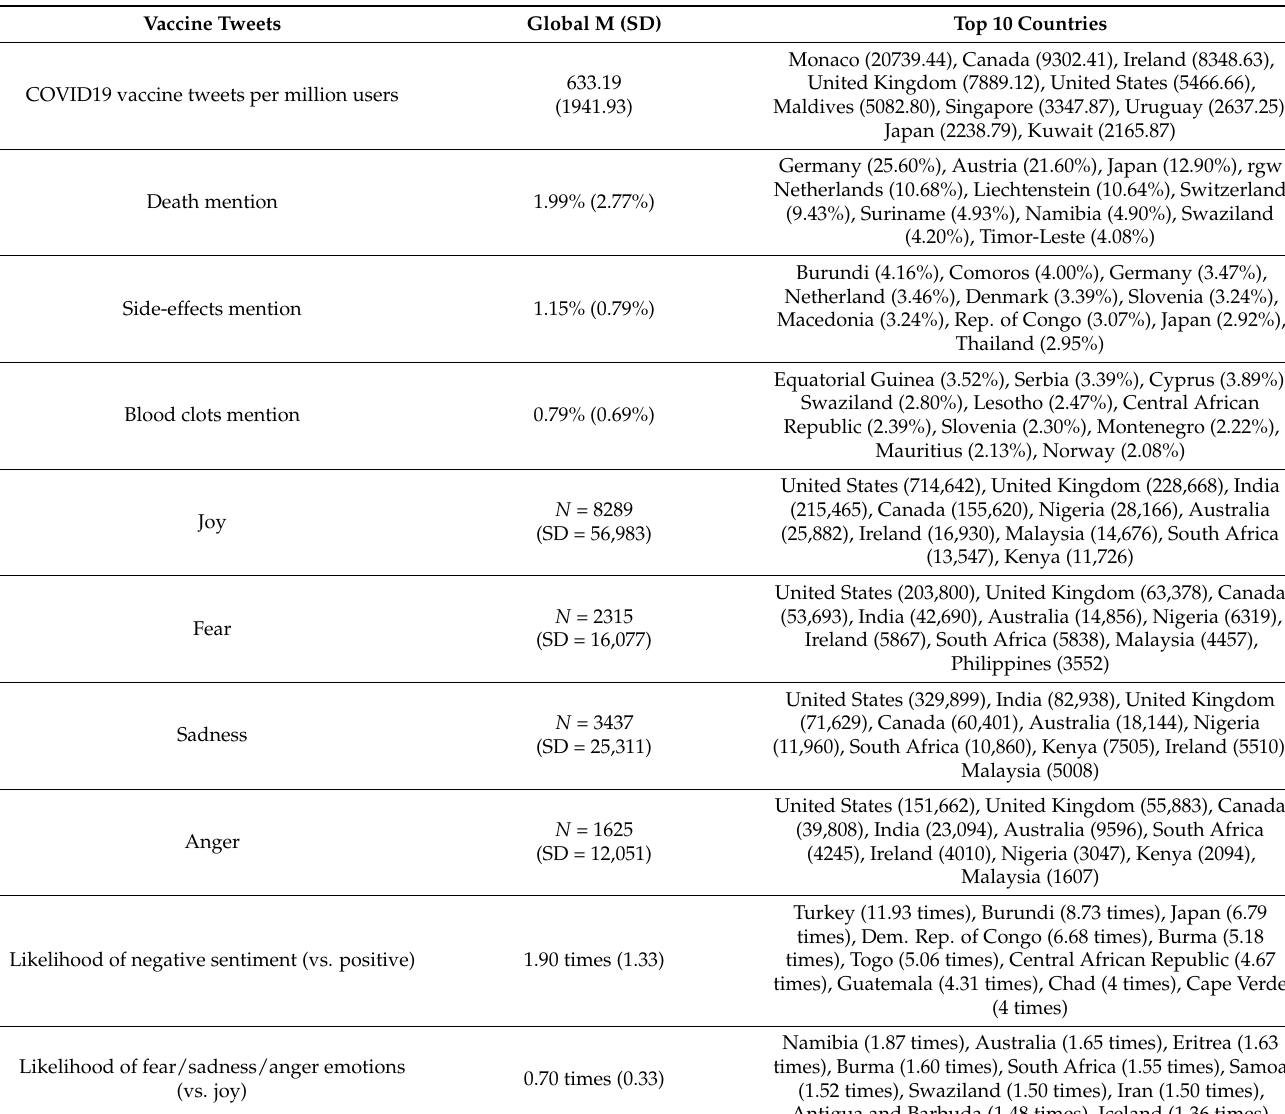
Table 2. Adverse Mentions, Negative Sentiment, and Emotions in COVID-19 Vaccine